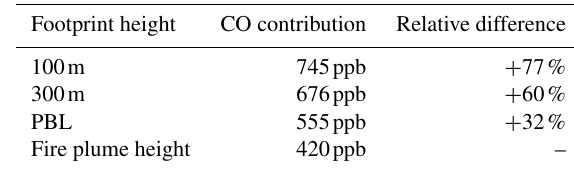
Table 3. Total CO contributions for different footprint layer heights and relative differences in reference to the results of fire plume top